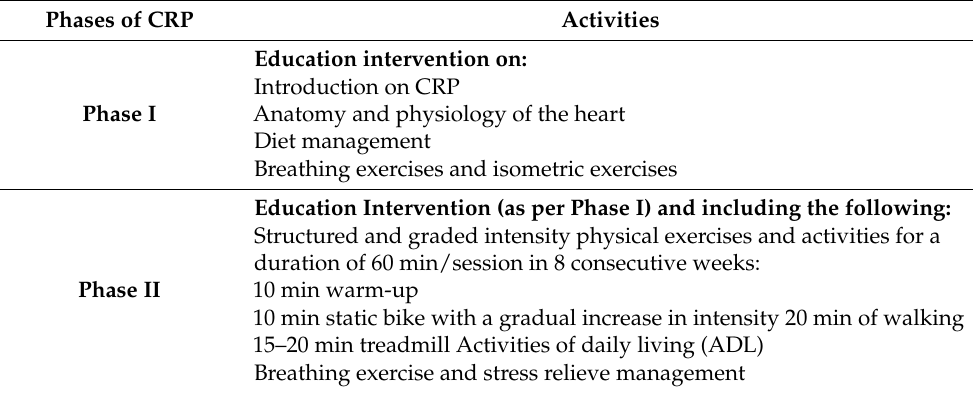
Table 1. Phase I and Phase II of Cardiac Rehabilitation Programs at selected study